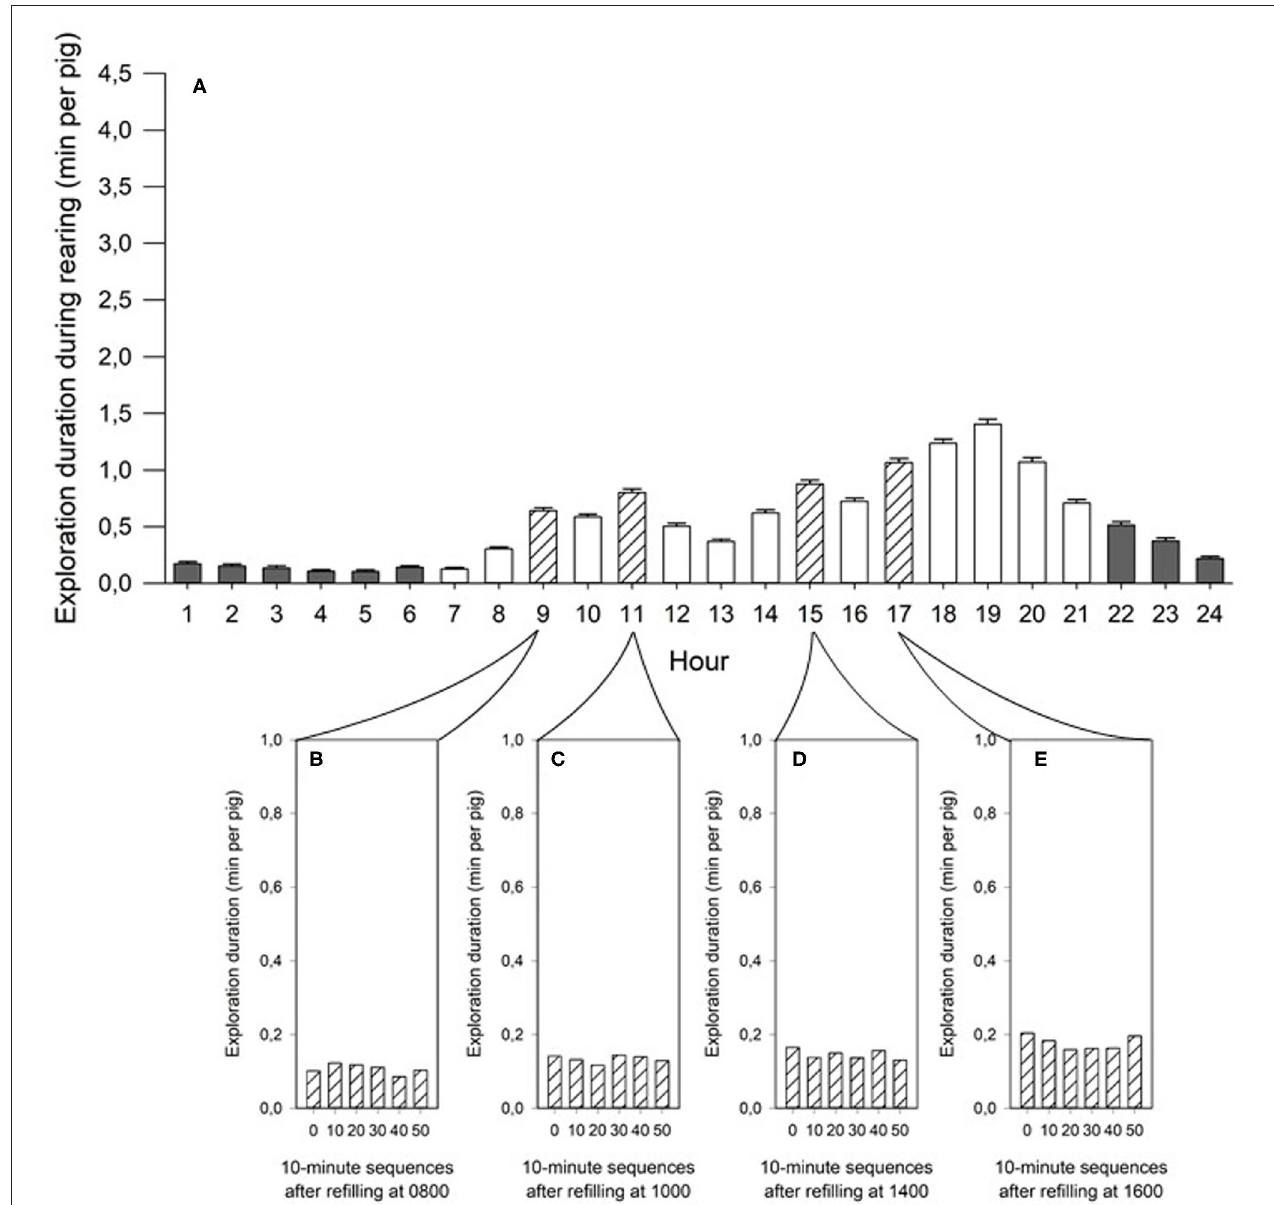
FIGURE 3 | (A) Diurnal pattern of exploration duration (mean ± SE minutes per piglet) at the dispenser filled with chopped straw in treatment R4 (four additional offers of chopped straw at 0800, 1000, 1400, and 1600) during rearing. (B–E) Exploration durations in 10-min sequences within the hours after refilling the rooting area (striped bars). Light bars indicate light phase and dark bars indicate dark